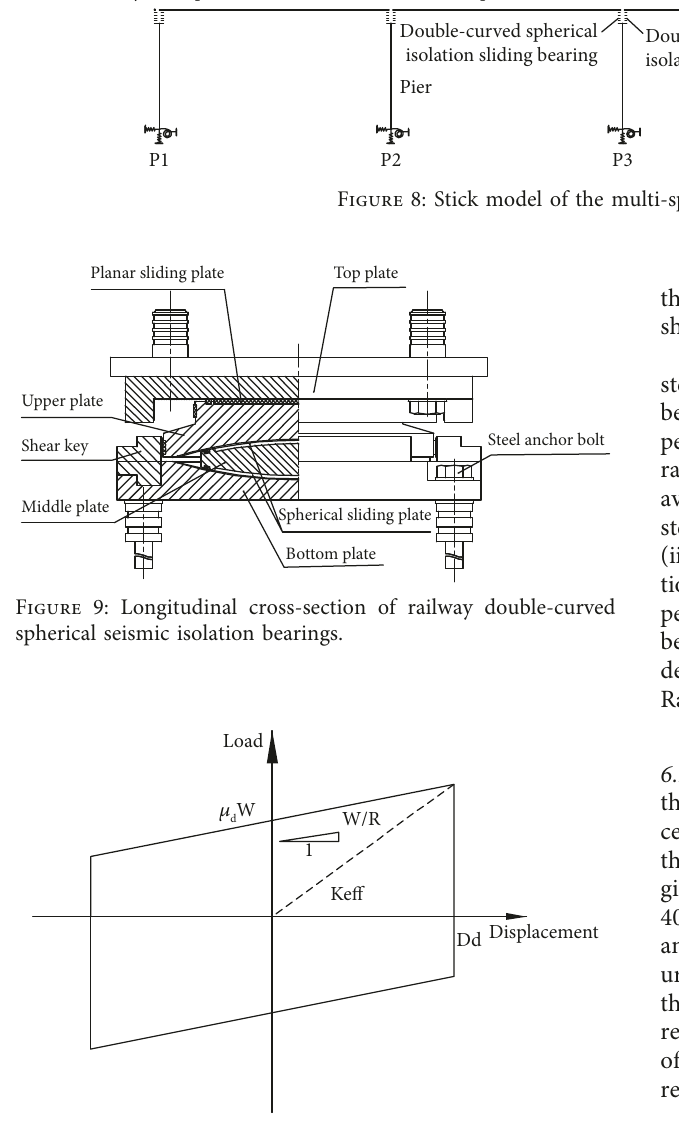
Figure 10: Hysteresis curve of